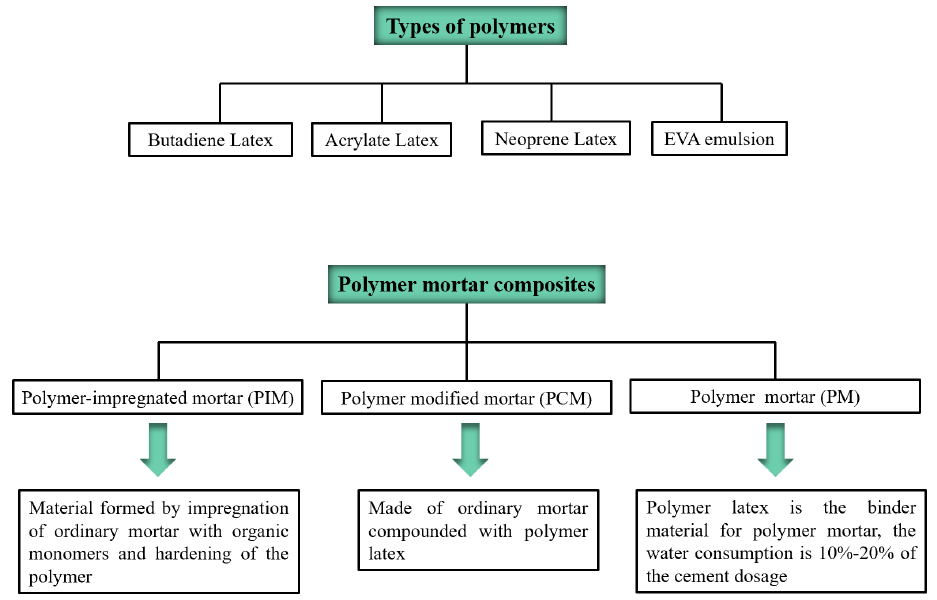
Figure 1. Types of polymers and classification of polymer mortar composite materials.